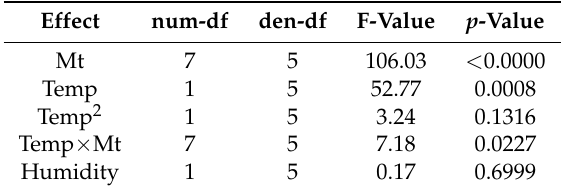
Table 8. Type III test of fixed effects of Model (6) related to